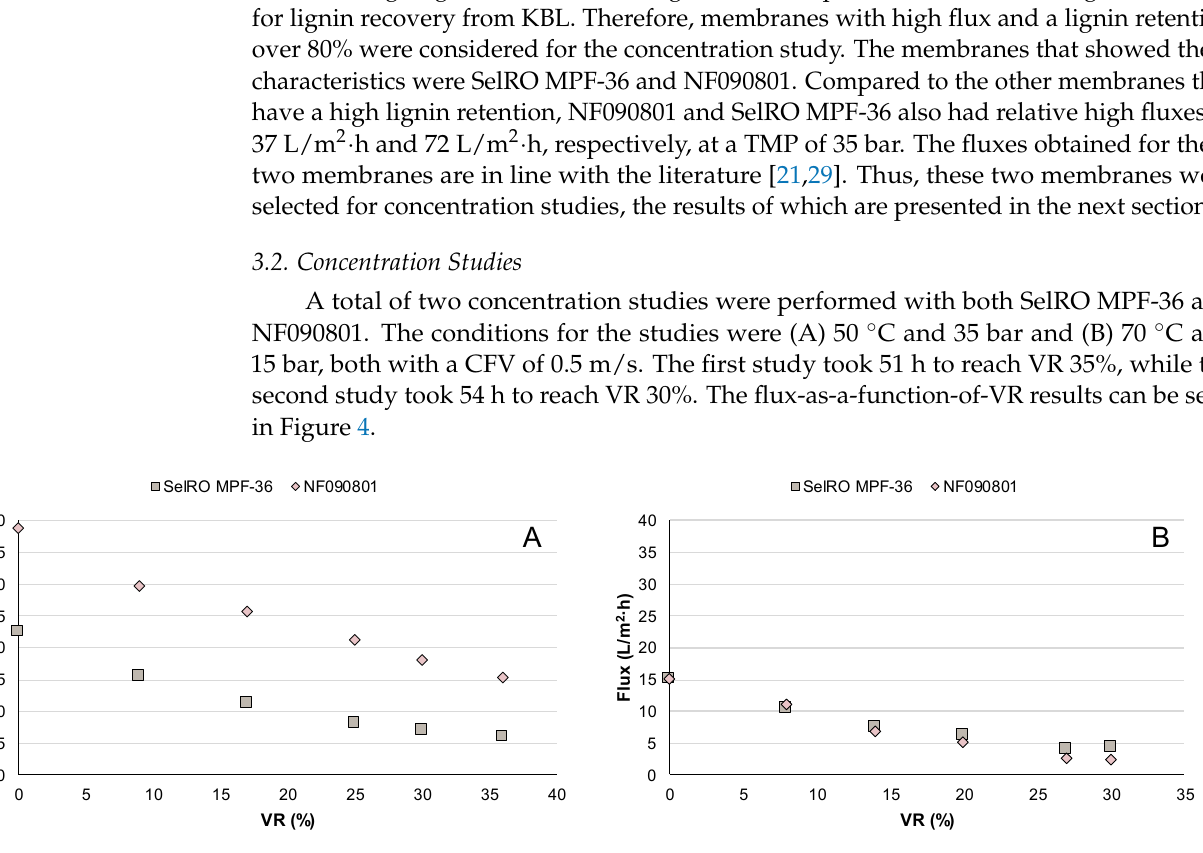
Figure 4. Flux vs VR during the concentration studies with the SelRO MPF-36 and NF090801 membranes at ( A ) condition A, 50 °C and 35 bar, and ( B ) condition B, 70 °C and 15 bar. The initial permeate flux of the NF090801 membrane was 38 L/m 2 ·h using condition A, which was more than double than the flux at condition B, 15 L/m 2 ·h. The difference in starting flux might be due to the TMP applied. As discussed in Section 3.1., flux increases with increasing TMP. The flux at condition A for NF090801 was in line with the one ob- tained during the parametric studies, which was 37 L/m 2 ·h.